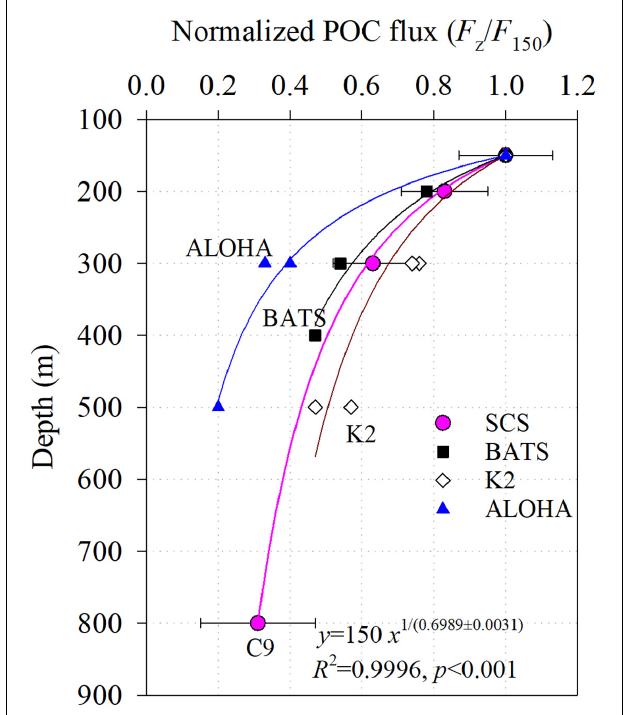
Based on Eq. (5), the POC auto , sed fluxes were estimated to be